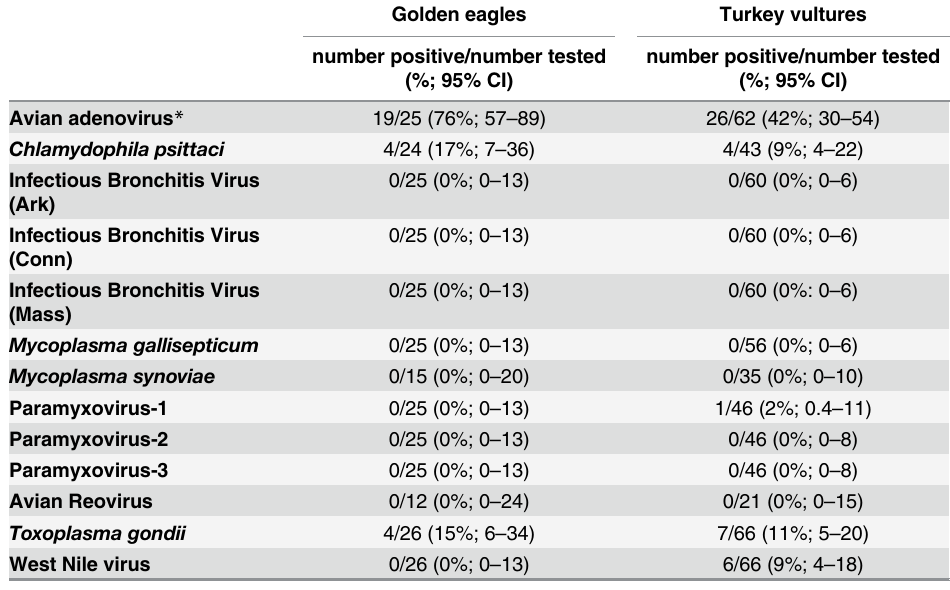
Table 2. Seroprevalence of potential pathogens in golden eagles and turkey